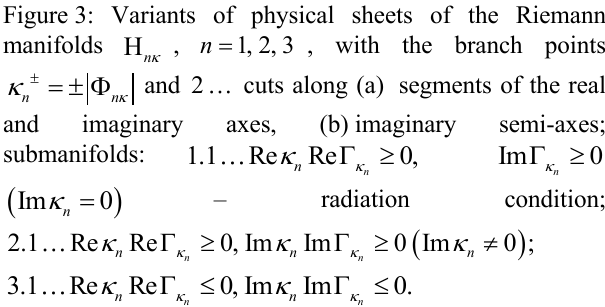
Re Re 0, Im Im 0 Im 0 ;